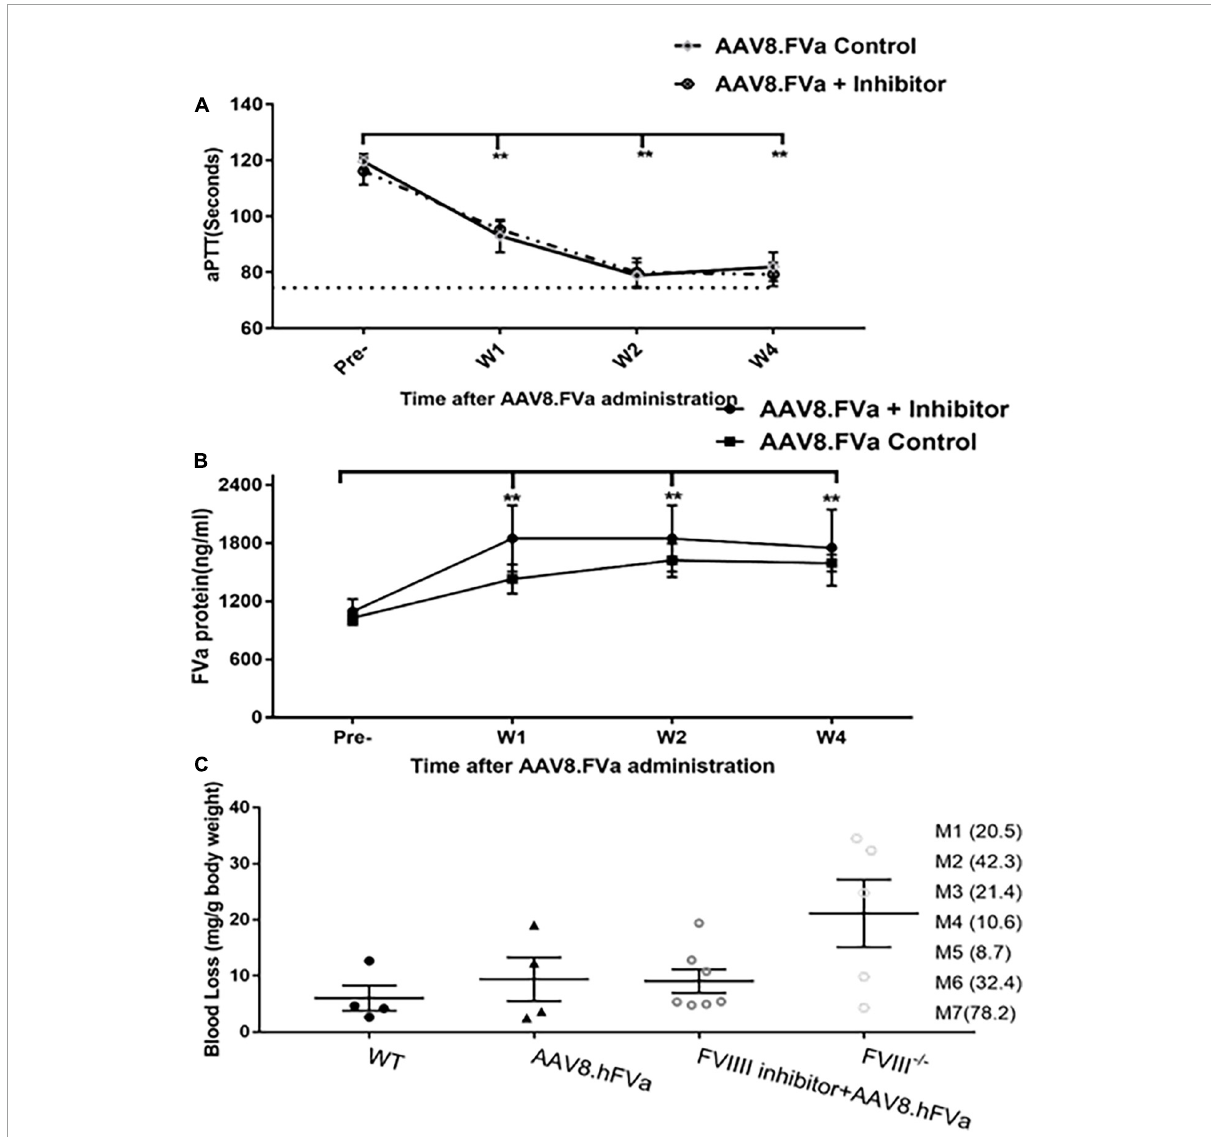
FIGURE5 Administration of AAV8/hFVa vectors improved hemostasis in hemophilia A mice with inhibitors. (A) FVIII - / - mice were first induced to develop anti-FVIII inhibitor by repeated FVIII protein infusion (“AAV8/hFVa + inhibitor,” N = 7). Hemophilia A without FVIII inhibitor was utilized as the controls (“AAV8/hFVa control,” N = 4). AAV8/hFVa vectors were administrated via the tail vein. Plasma was collected for aPTT assay at different time points. ** Compared with pre-treatment, P < 0.01 (two-way ANOVA with multiple comparisons and unpaired t -tests). (B) Plasma from the same mice (“A”) was measured for hFVa by ELISA. N = 6 for “AAV8/hFVa + inhibitor”; N = 4 for “AAV8/hFVa control.” ** Compared with pre-treatment, P < 0.01 (two-way ANOVA with multiple comparisons and unpaired t -tests). (C) Eight weeks post-AAV8/hFV injection, FVIII - /